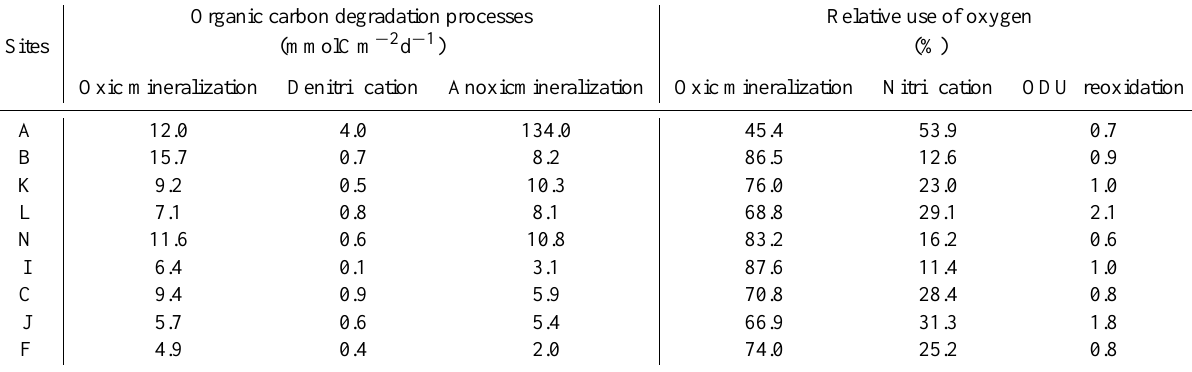
Table 4. Degradation rates of organic carbon by oxic mineralization, denitrification, and anoxic mineralization (in mmolCm − 2 d − 1 ) (left); and the relative contribution to the oxygen consumption by oxic mineralization, nitrification, and ODUs reoxidation (in %) (right). Organic carbon degradation processes Relative use of oxygen Sites Denitrification Oxic